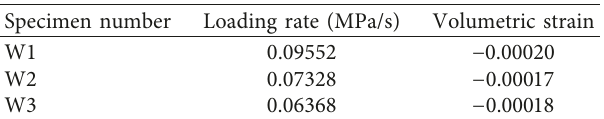
Table 3: The volumetric strain of the specimens under the nitrogen gas fracturing pressure